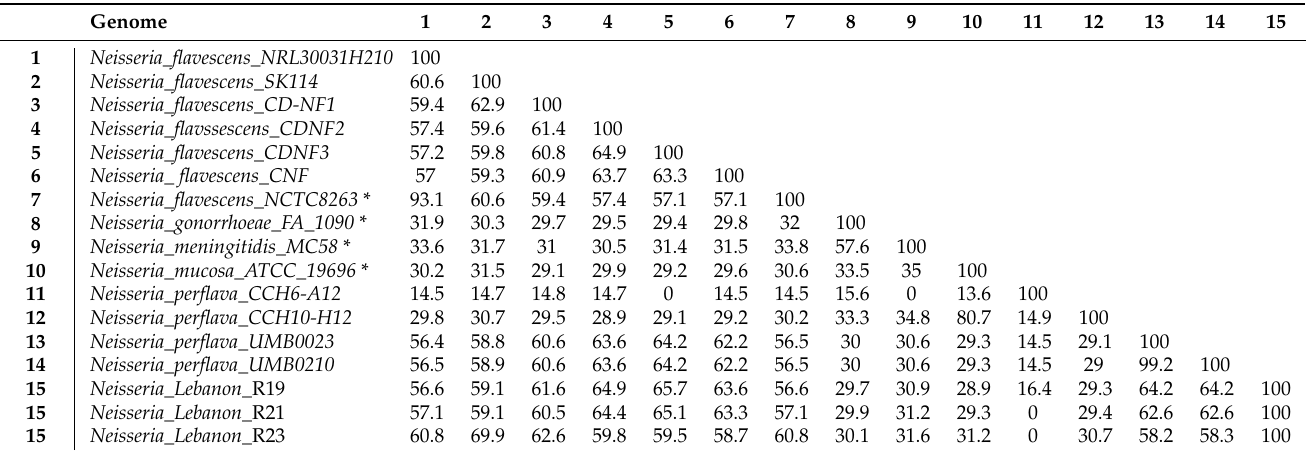
Table 2. Comparison of N. flavescens R19, R21, and R23 with related Neisseria spp. using GGDC, formula 2 (DDH estimates based on identities/high scoring segment pair (HSP)